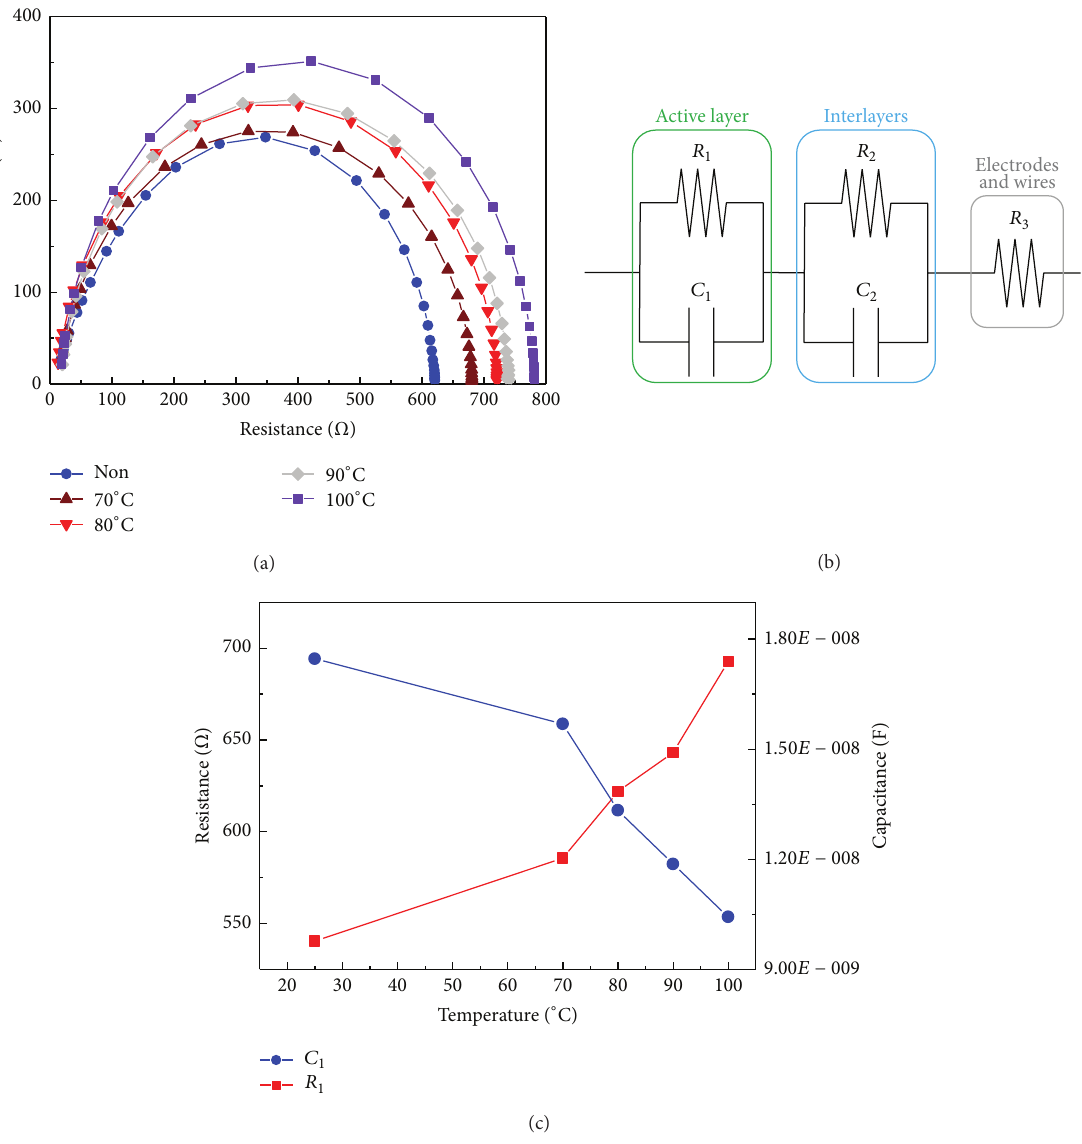
Figure 6: The (a) Cole-Cole plot, (b) equivalent circuit, and (c) simulated data of 𝑅 1 and 𝐶 1 of the OPV devices with the PBDTTT-C:PC 71 BM layers heated under different temperatures for 5